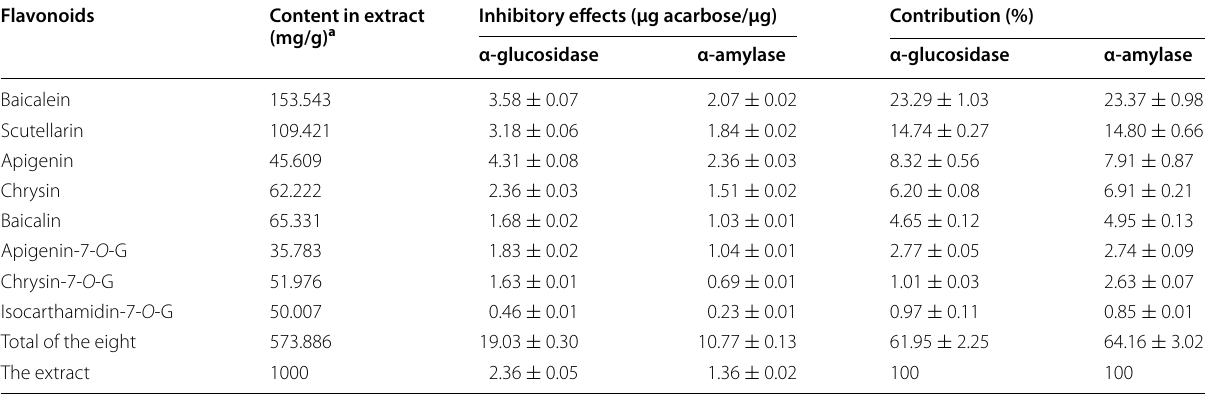
Data are the mean G : glucuronide a The content of each flavonoid was cited from supplementary material of Li et al. [20]